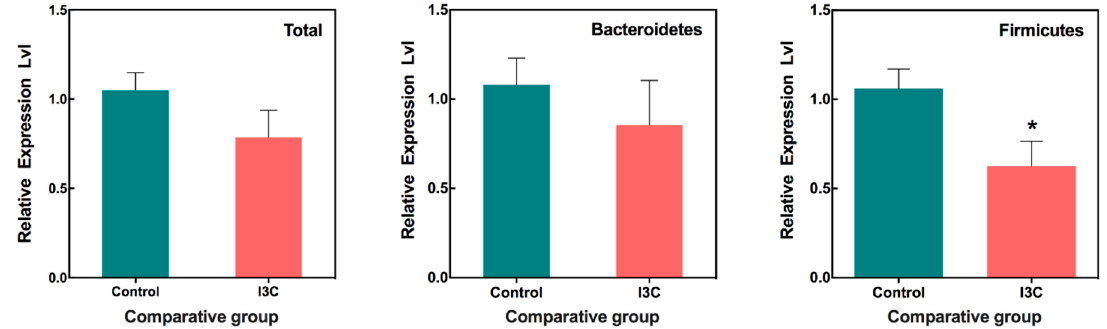
Figure 5. Alteration of fecal microbiota in mice fed with or without I3C. Bacterial DNA isolated from feces. Quantification of bacteria was performed with specific primers using qRT-PCR. Columns marked are significantly different from each other ( p < 0.05, Mean ± SD, n =